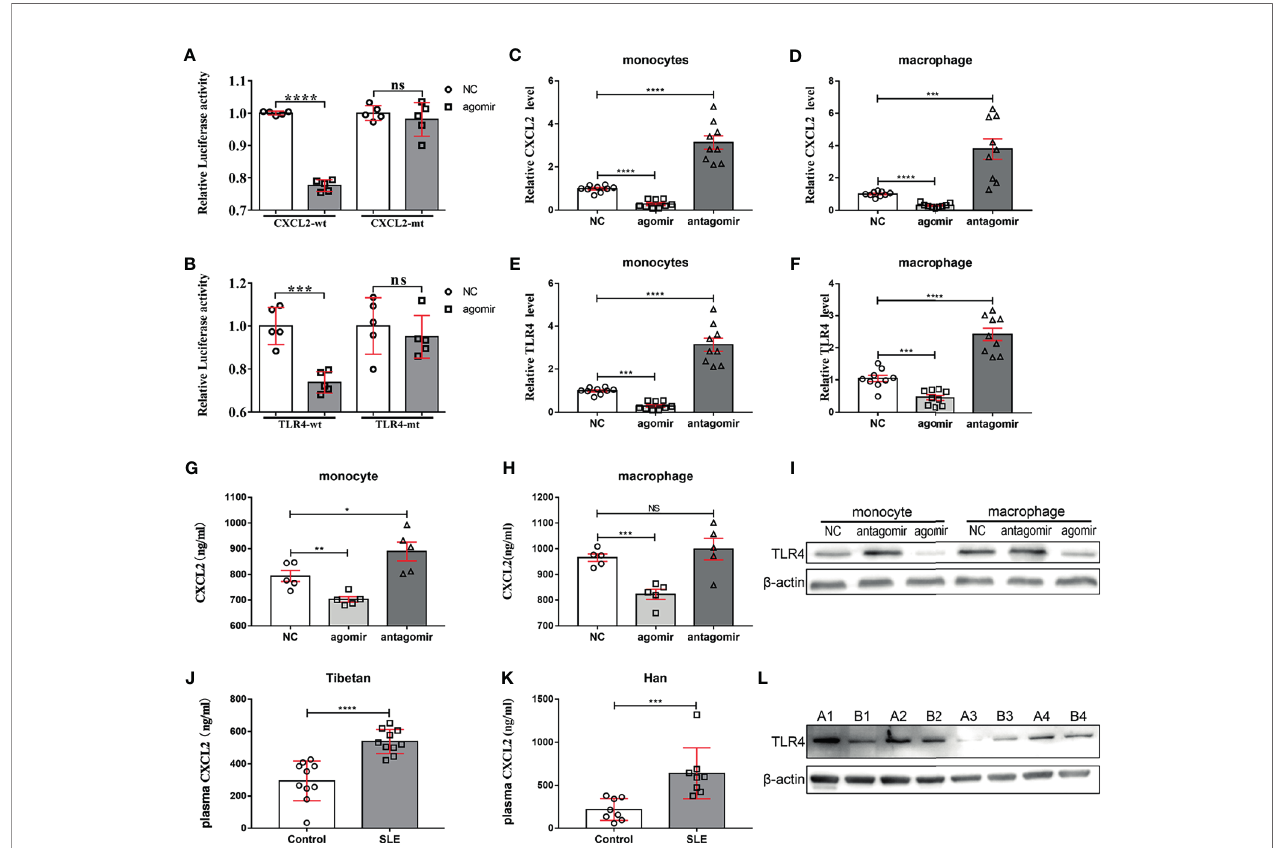
FIGURE 2 | miR-4512 directly targets TLR4 and CXCL2 . (A, B) Luciferase activity of WT/MUT-CXCL2 and WT/MUT-TLR4 plasmids in HEK293T following transfection with an miR-4512 agomir. Data are presented as the mean ± SEM. **** P < 0.0001; *** P < 0.001; NS = not signi fi cant. (C – F) RT-qPCR analysis of CXCL2 and TLR4 transcript levels in human primary monocytes and macrophages 48 h after transfection with NC/miR-4512 agomiR/antagomiR. Data are presented as the mean ± SEM. **** P < 0.0001; *** P < 0.001. (G, H) CXCL2 concentration in the supernatants obtained from human primary monocytes (G) and